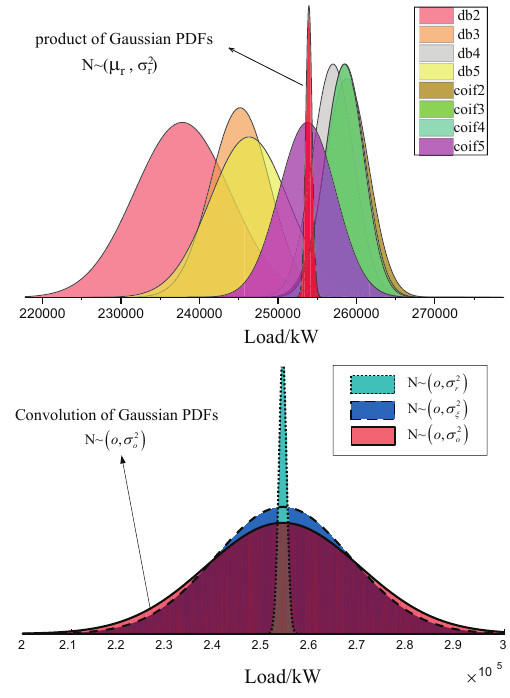
Figure 7. The product and convolution of Gaussian probability density functions (PDFs) on an exact load